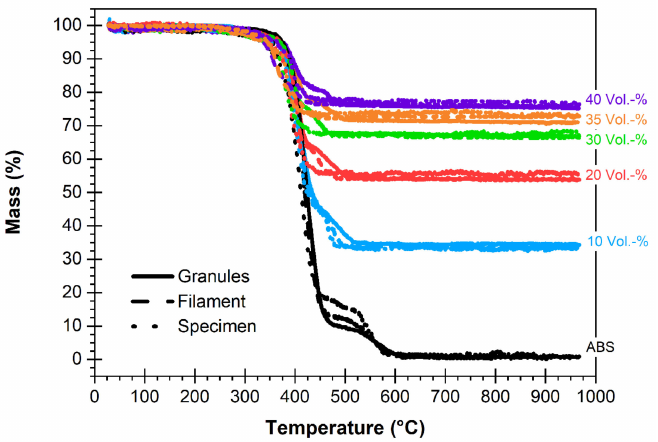
Figure 10. Validation of the consistency of the composite composition during processing via thermographimetric